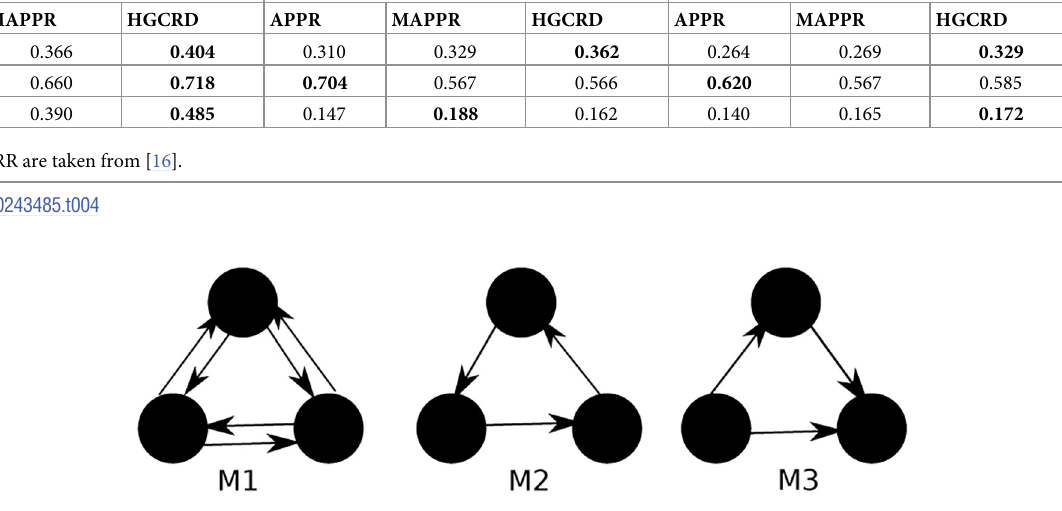
Fig 5. Three directed motifs used for clustering Email-EU graph, which are a triangle in any direction (M1), a cycle (M2), and a feed-forward loop